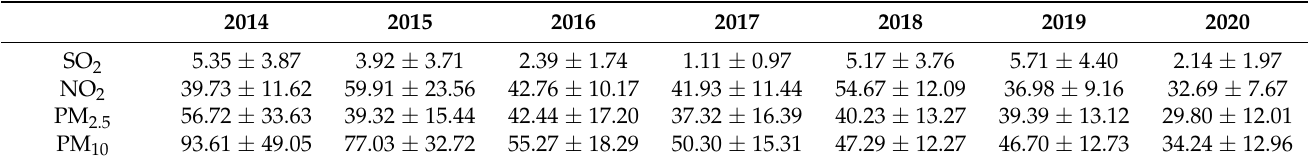
Table 1. Seasonal SO 2 , NO 2 , PM 2.5 and PM 10 data ( µ g m –3